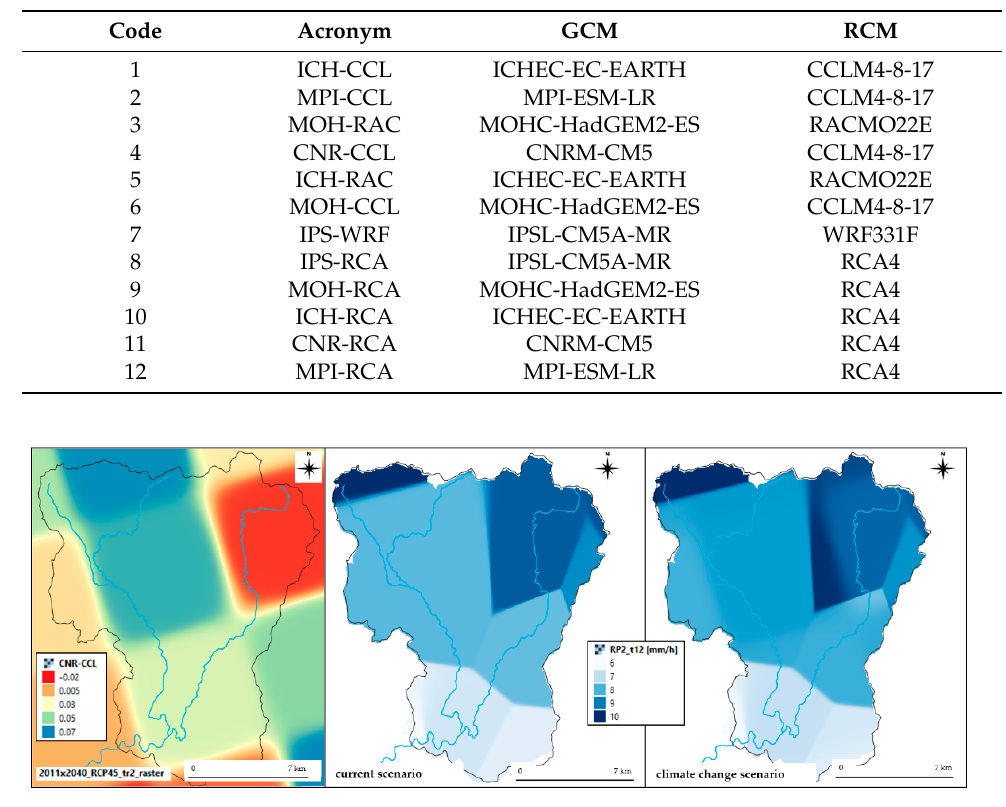
Figure 1. Combination of the delta changes with the design rainfall to obtain the rainfall spatial distribution in the future.